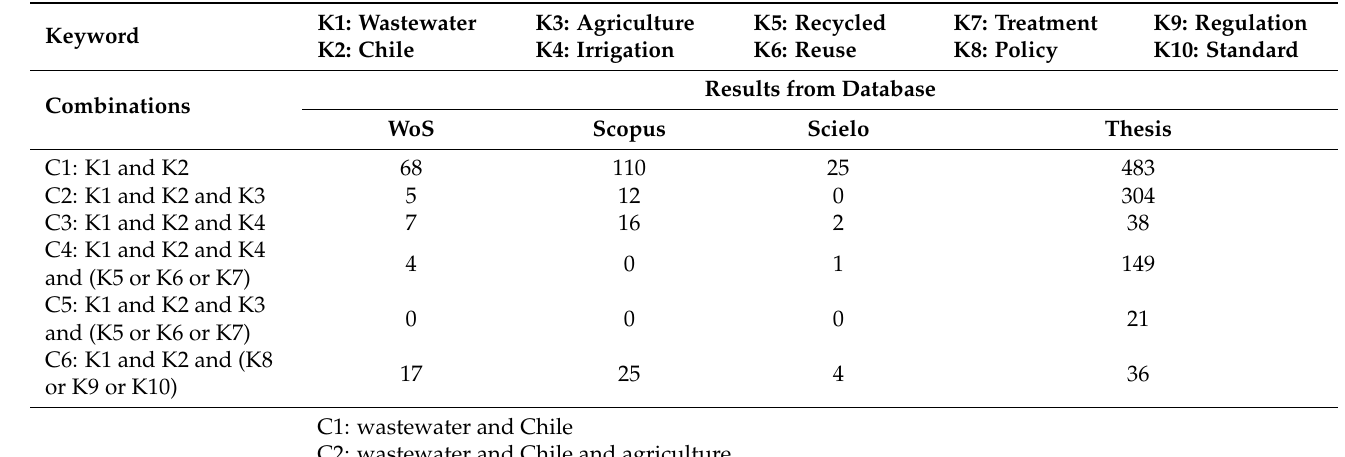
Table 1. Keyword combinations used to obtain information about recycled wastewater reuse for irrigation as employed in the SLR process (includes only scientific databases and thesis databases of Chilean